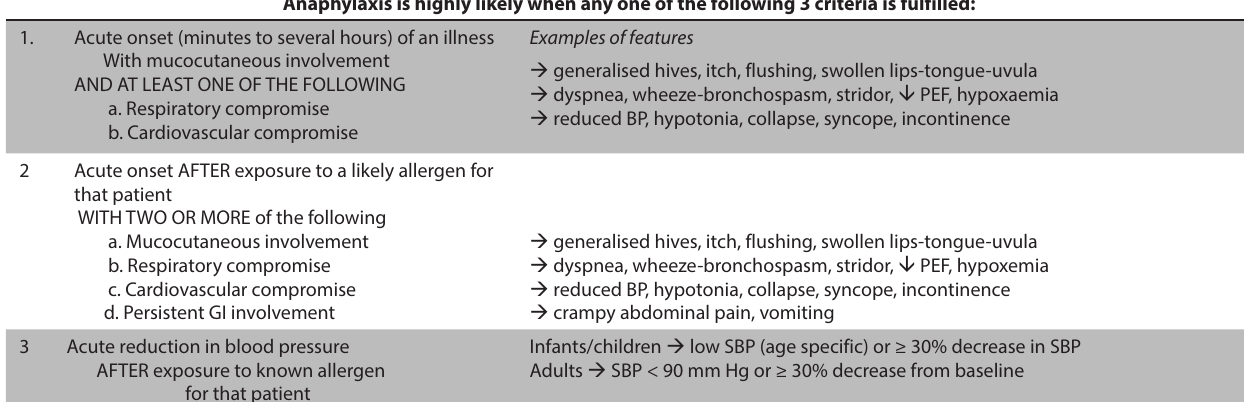
Table 5: Clinical Criteria for Diagnosing Anaphylaxis adapted from 34